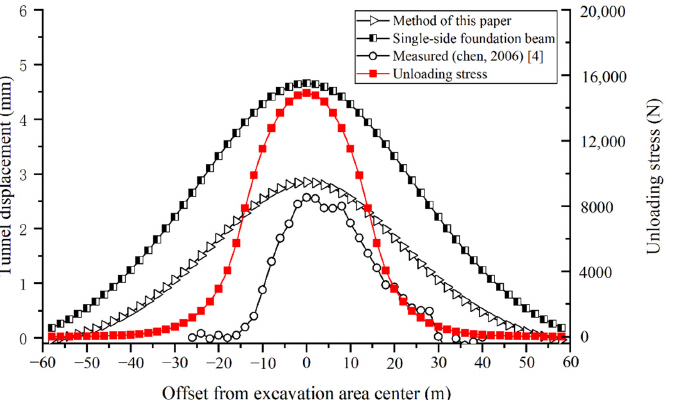
Figure 9. Comparison between the measured and calculated tunnel displacements due to the M8 above-crossing north shield tunnel of Line 2.